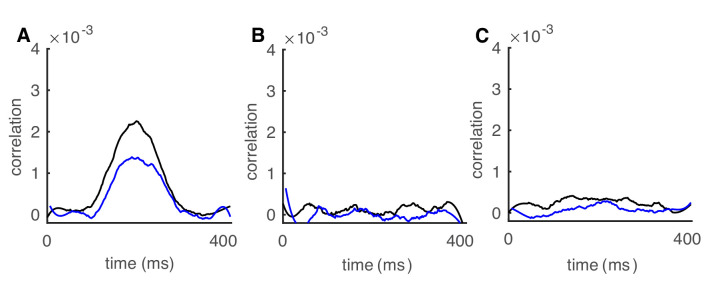
Transient correlations for a 2.5 Hz sine wave.(A) The 0 ms-time lag (black) and 6 ms-time lag (blue) correlations between increased-rate neurons in the network increase with population rates (n = 100). (B) Correlations between decreased-rate neurons in the network (n = 30). (C) Correlations between increased-rate neurons and decreased-rate neurons (n = 30 for each group).